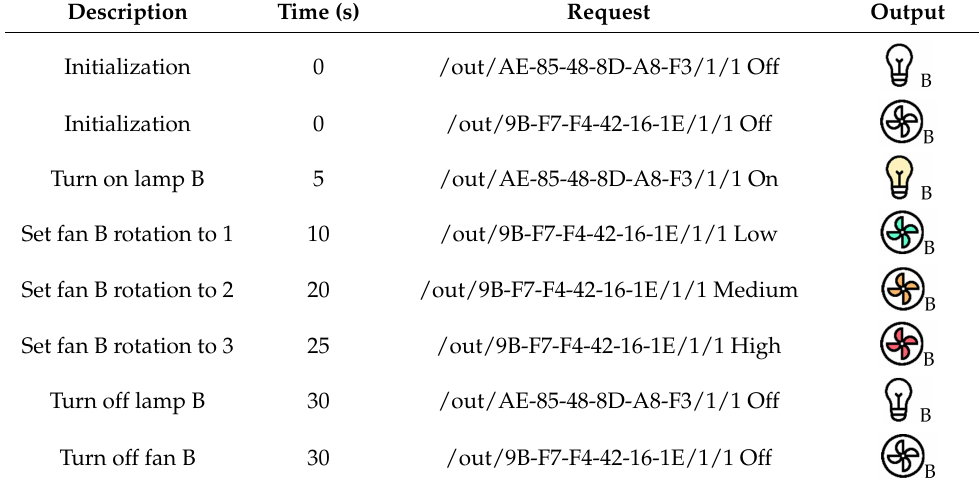
Table 6. Two-dimensional virtual environment devices: schedule-oriented control testing